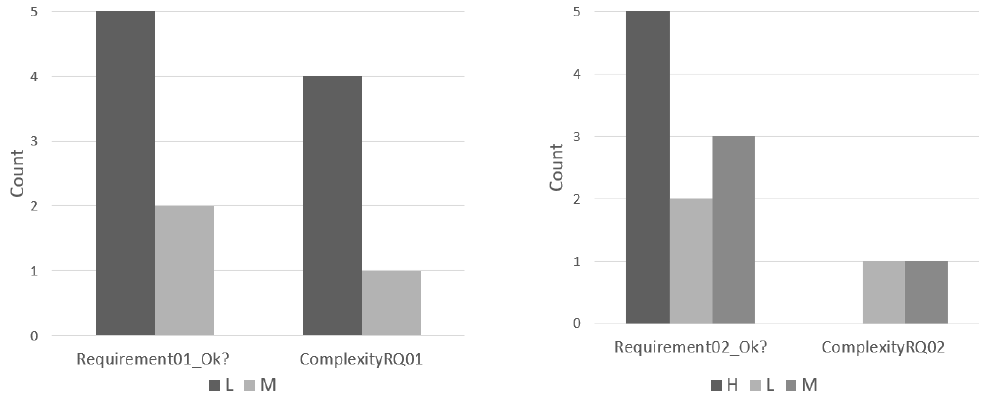
Figure 13. Answers distribution considering complexity of